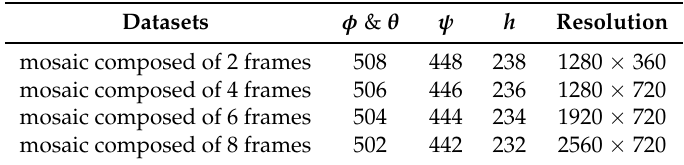
Table 4. Number of mosaic images in the datasets used to evaluate the models for the flight commands ( φ , θ , ψ , h